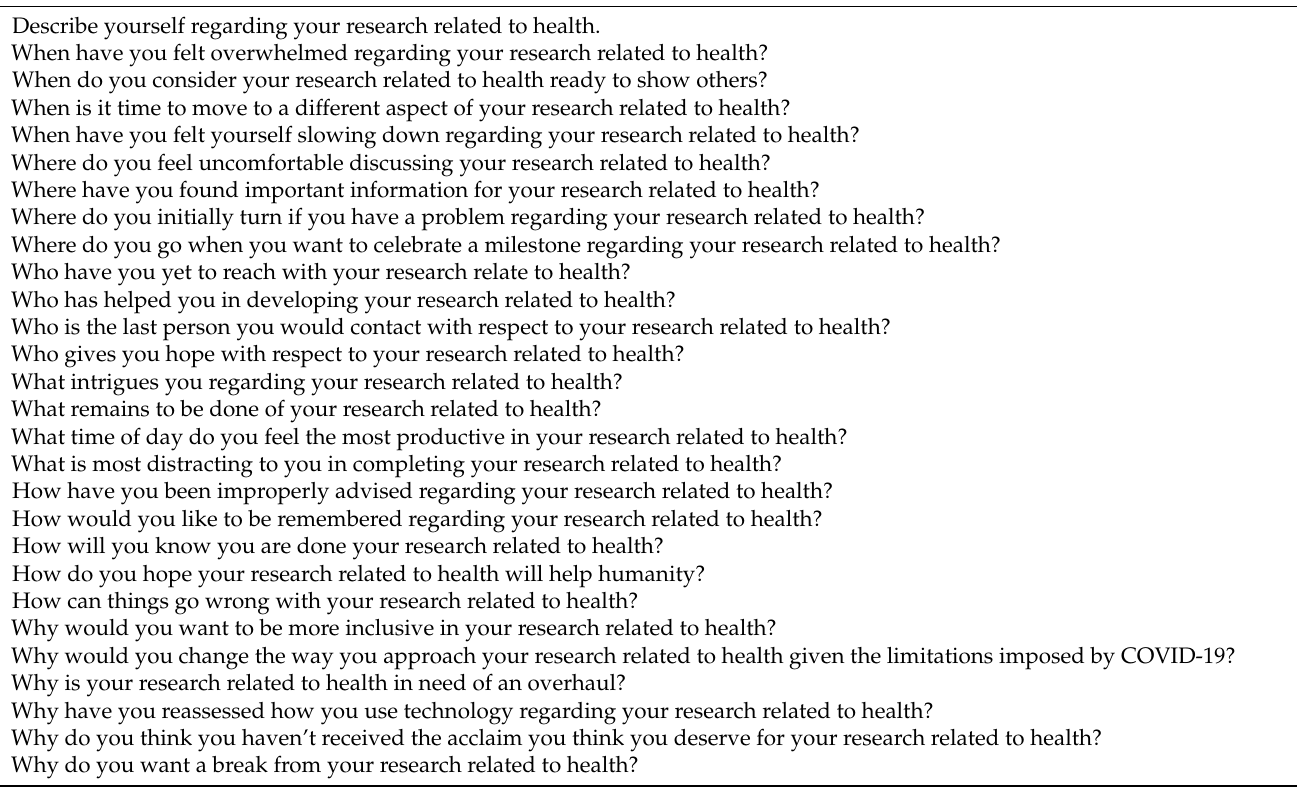
Table 2. The writing prompts provided to the HeNReG members through the Messenger app over the 28 weeks of the 2020–2021 academic year in the order in which they were presented to group members by the facilitator the day before the weekly meeting and to which they responded in writing through Messenger by the time of the weekly